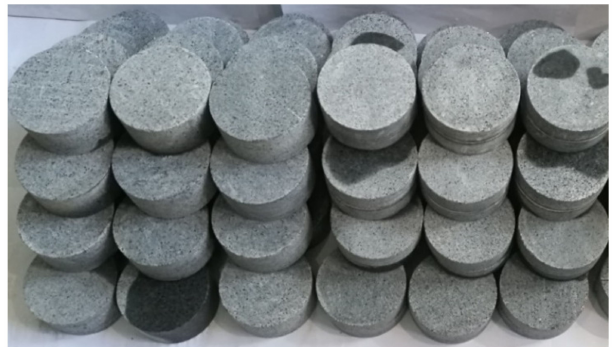
Figure 1. The rock